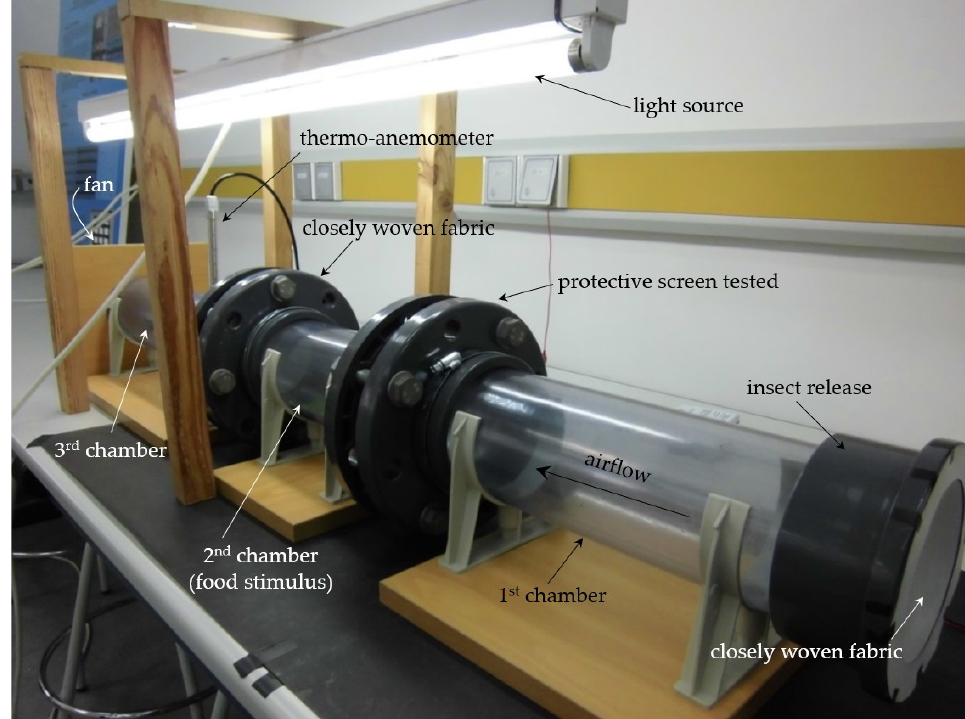
Figure 6. Experimental device for measuring the protective efficacy of